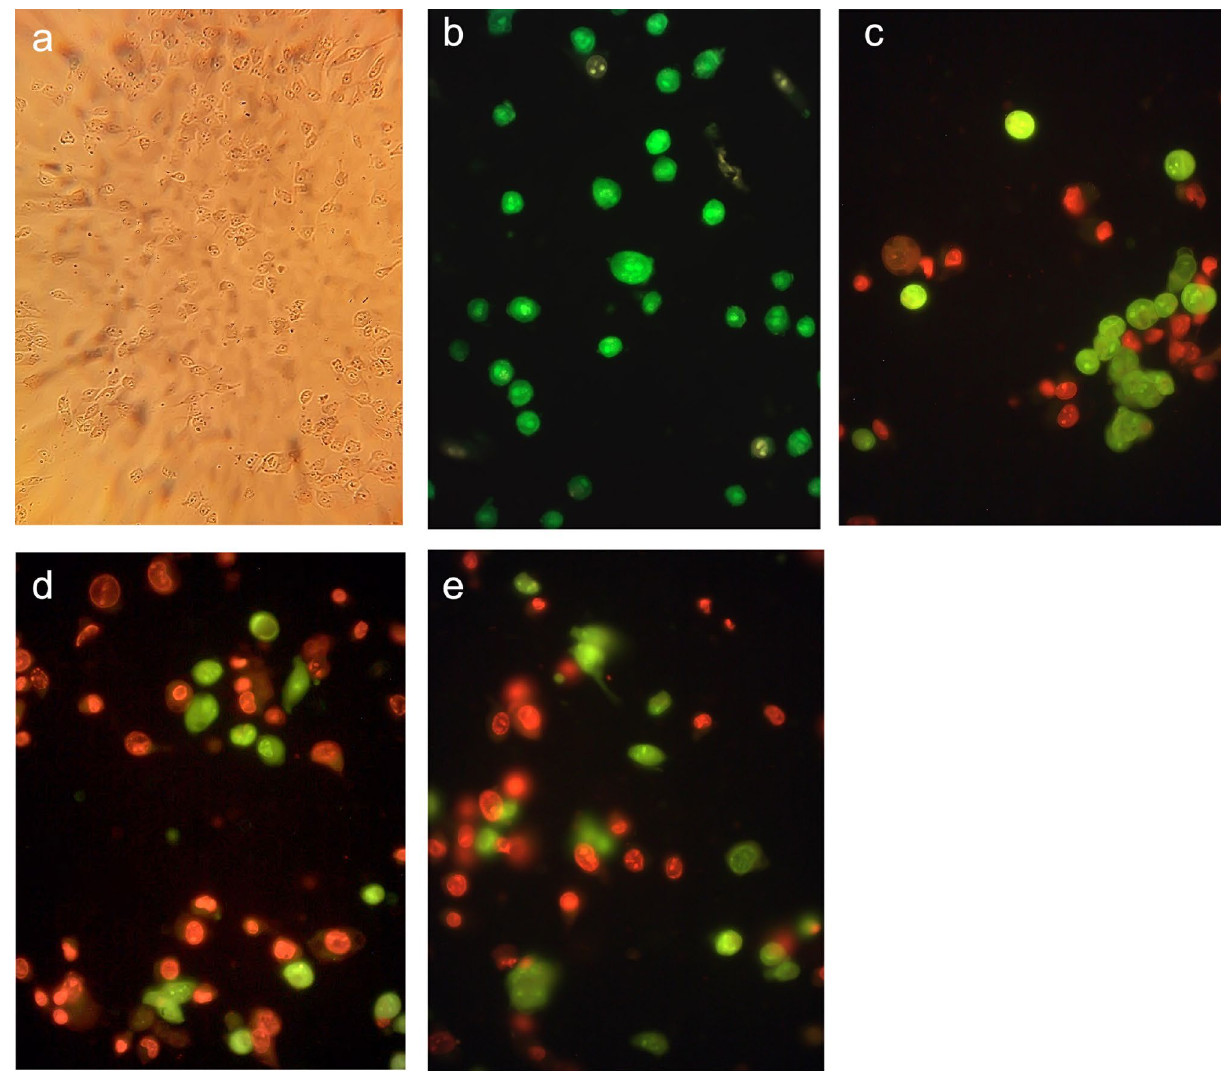
Figure 5. ( a ) Treated A549 cells with OEO (IC 50 ) under an inverted microscope. ( b ) Control A549 cells and ( c ) treated cells with OEO (1/2IC 50 ) for 24 h. ( d ) Treated cells with OEO (IC 50 ) for 24 h. ( e ) Treated cells with Etoposide (positive control) (IC 50 ) for 24 h. The cells were stained using AO and EtBr and visualized with fluorescence